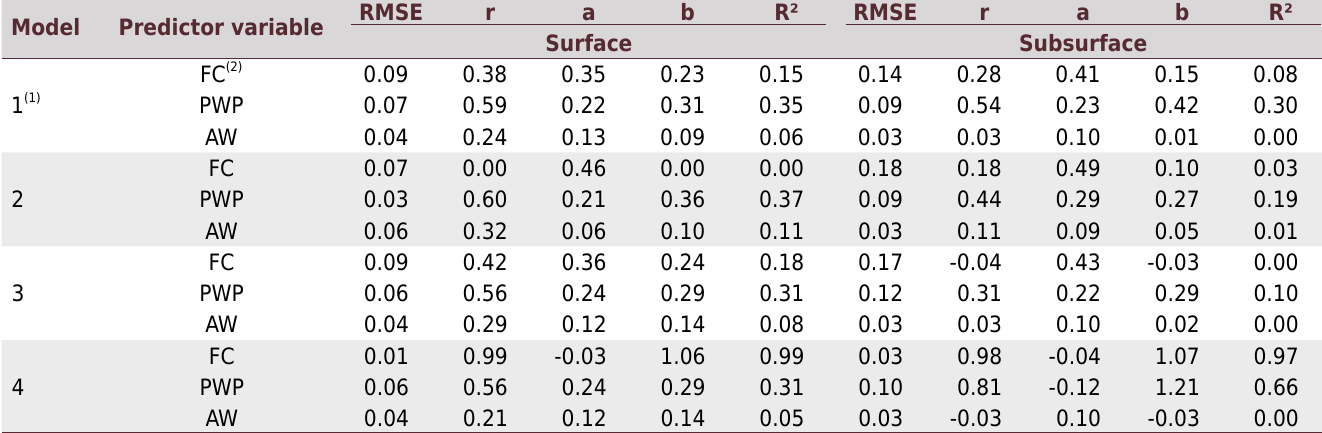
Table 3. Root mean square error (RMSE), correlation coefficient (r), intercept (a), angular coefficient (b), and coefficient of determination (R²) between measured and estimated moisture by multiple linear regressions (MLR) in four models validated with the surface and subsurface horizons database Model Predictor